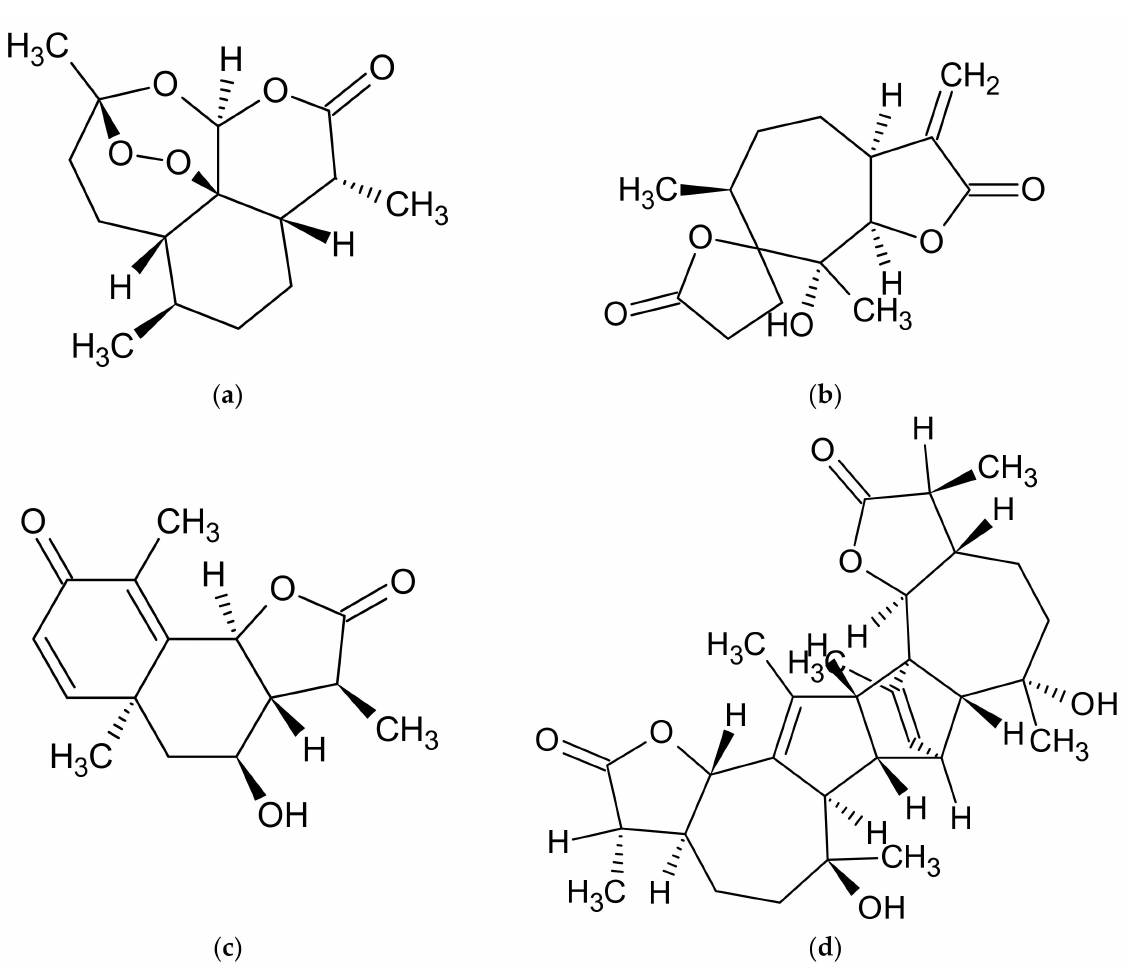
Figure 1. Chemical structure of sesquiterpenoid lactones found in Artemisia species: artemisinin ( a ); psilostachyin ( b ); artemisin ( c ); absinthin ( d